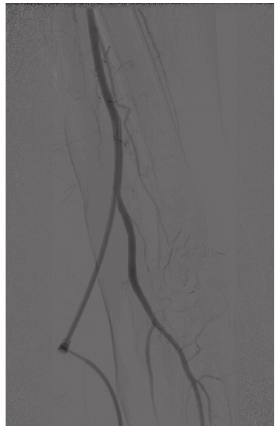
Figure 1: Angiography of the left brachial artery at the end of the first procedure after placement of a 6F-10cm sheath.